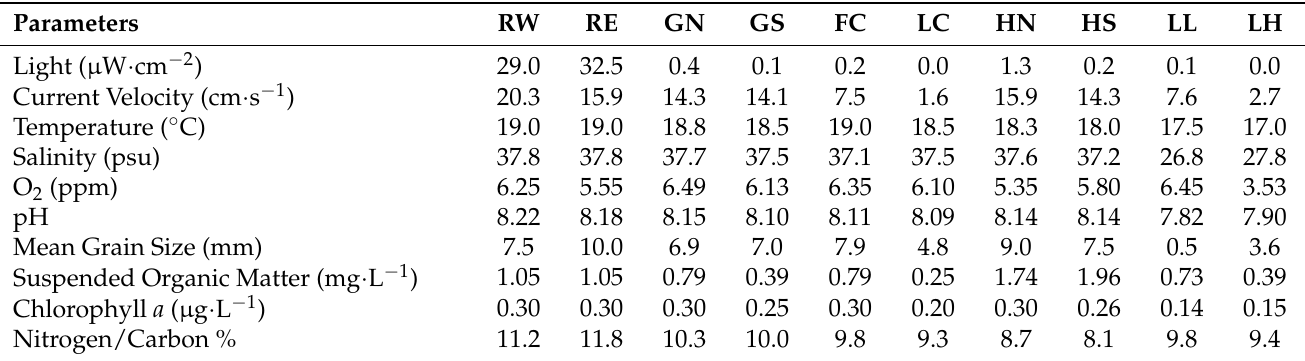
Figure 7. Simplified map of the submerged part of the Grotta Marina of Bergeggi with main toponyms and sampling points. RW = Remo’s Cavern West; RE = Remo’s Cavern East; GN = Gulley North; GS = Gulley South; FC = First Chamber; LC = Lights’ Chamber; HN = Hall North; HS = Hall South; LL = Lemons’ Lake; LH = Lake through the Hole. Inset: location of Bergeggi in Italy. Table 3. Environmental data measured in July 1986 in different stations of the Grotta Marina di Bergeggi [19,20].